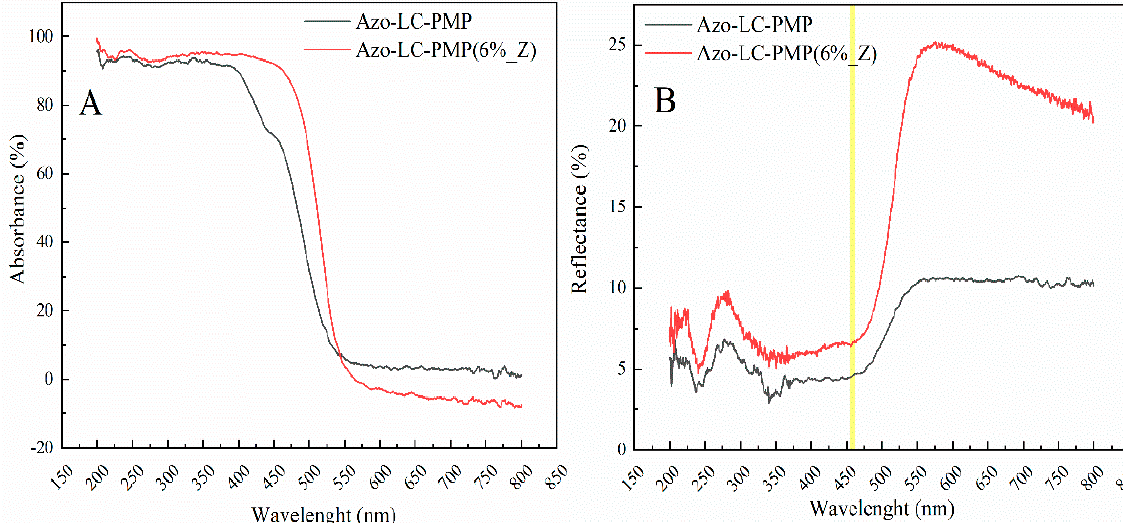
Figure 11. Comparison between the spectra of ( A ) absorbance, and ( B ) reflectance of both Azo-LC-PMP and doped Azo-LC-PMP Z.